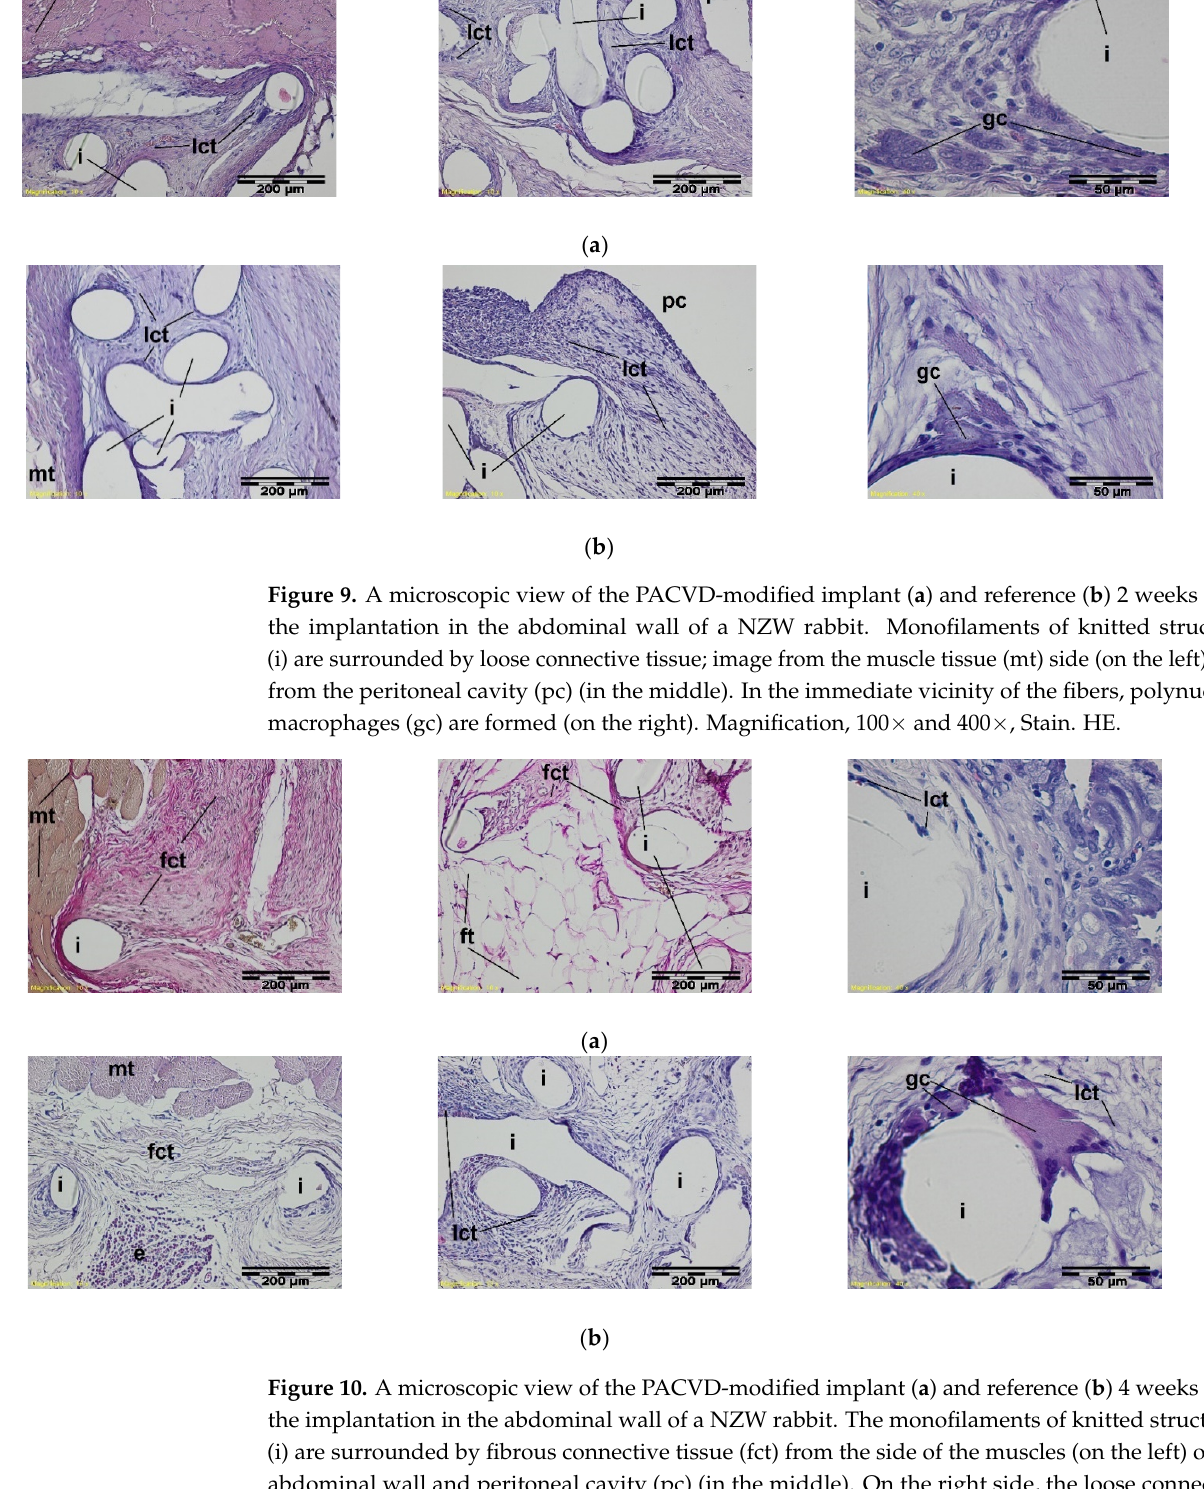
abdominal wall and peritoneal cavity (pc) (in the middle). On the right side, the loose connective tissue (lct) with polynuclear macrophages (gc) appears in the immediate vicinity of the monofila-